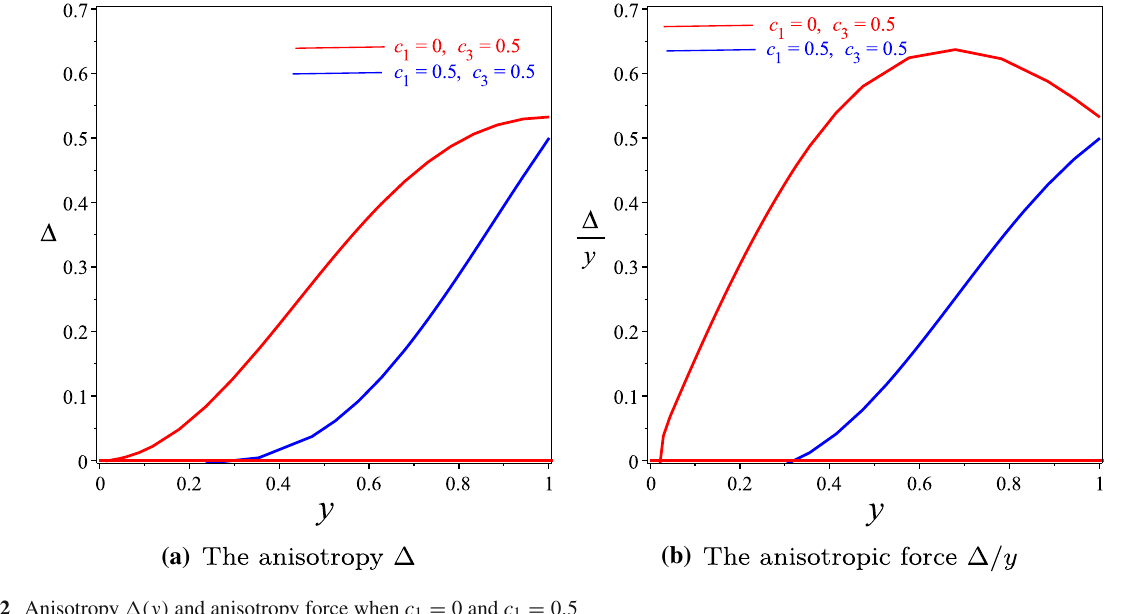
Fig. 2 Anisotropy (cid:15)( y ) and anisotropy force when c 1 = 0 and c 1 = 0 . 5